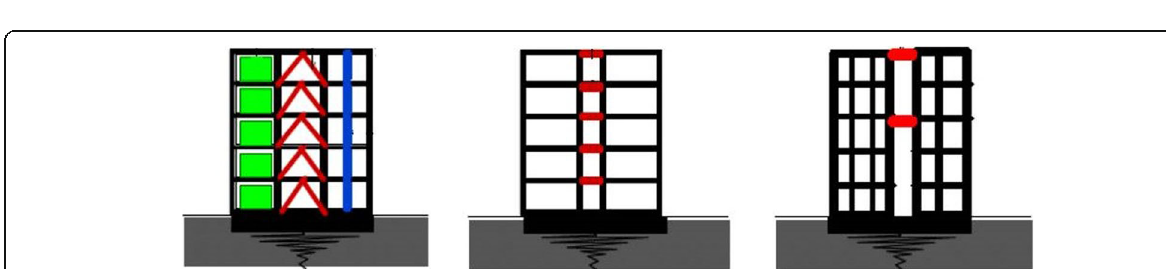
Fig. 15 Configurations of so-called passive-type response control method